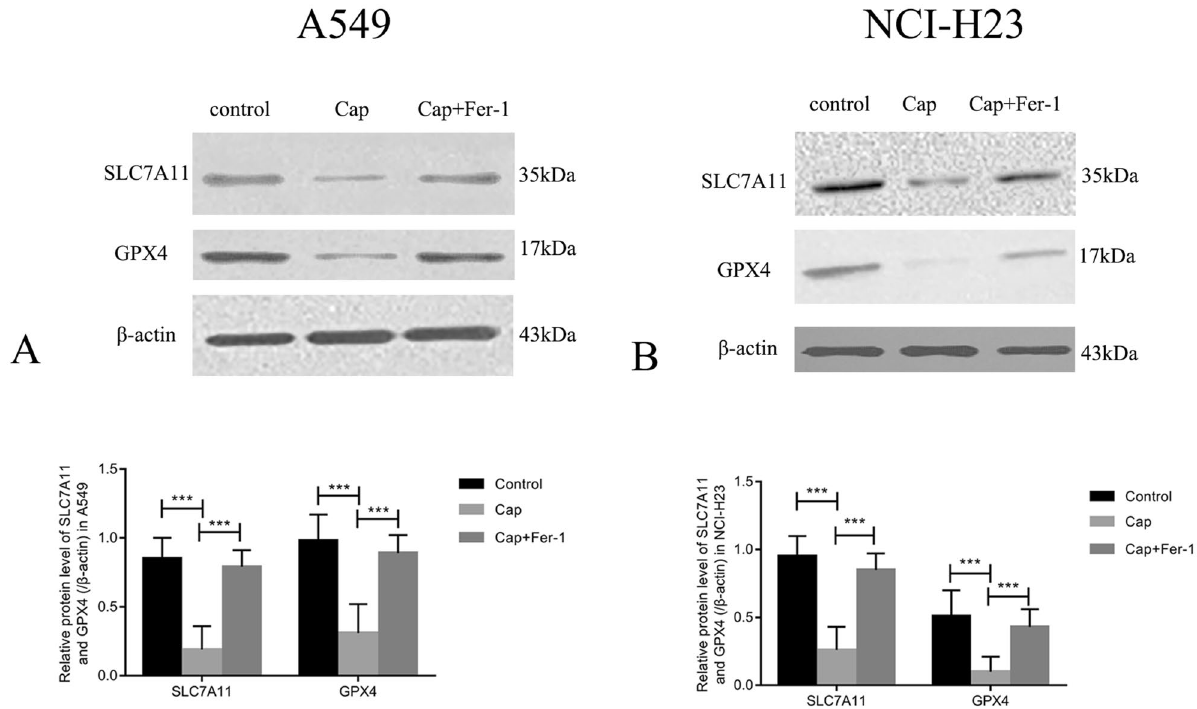
Figure 4. The expressions of SLC7A11 and GPX4 were analyzed by Western blotting analysis. ( A ) SLC7A11 and GPX4 protein expressions in A549 cells. ( B ) SLC7A11 and GPX4 protein expressions in NCI-H23 cells. (*** P <